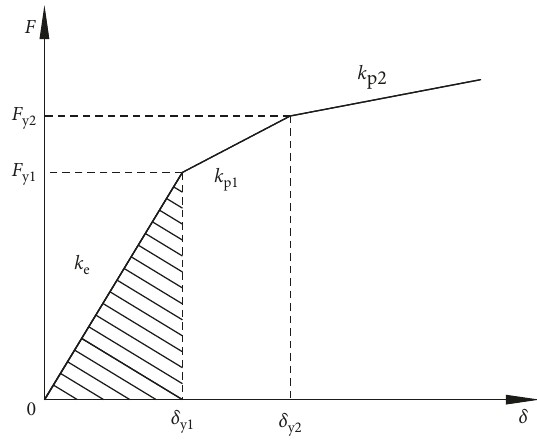
Figure 4: Idealized F-δ diagram of the